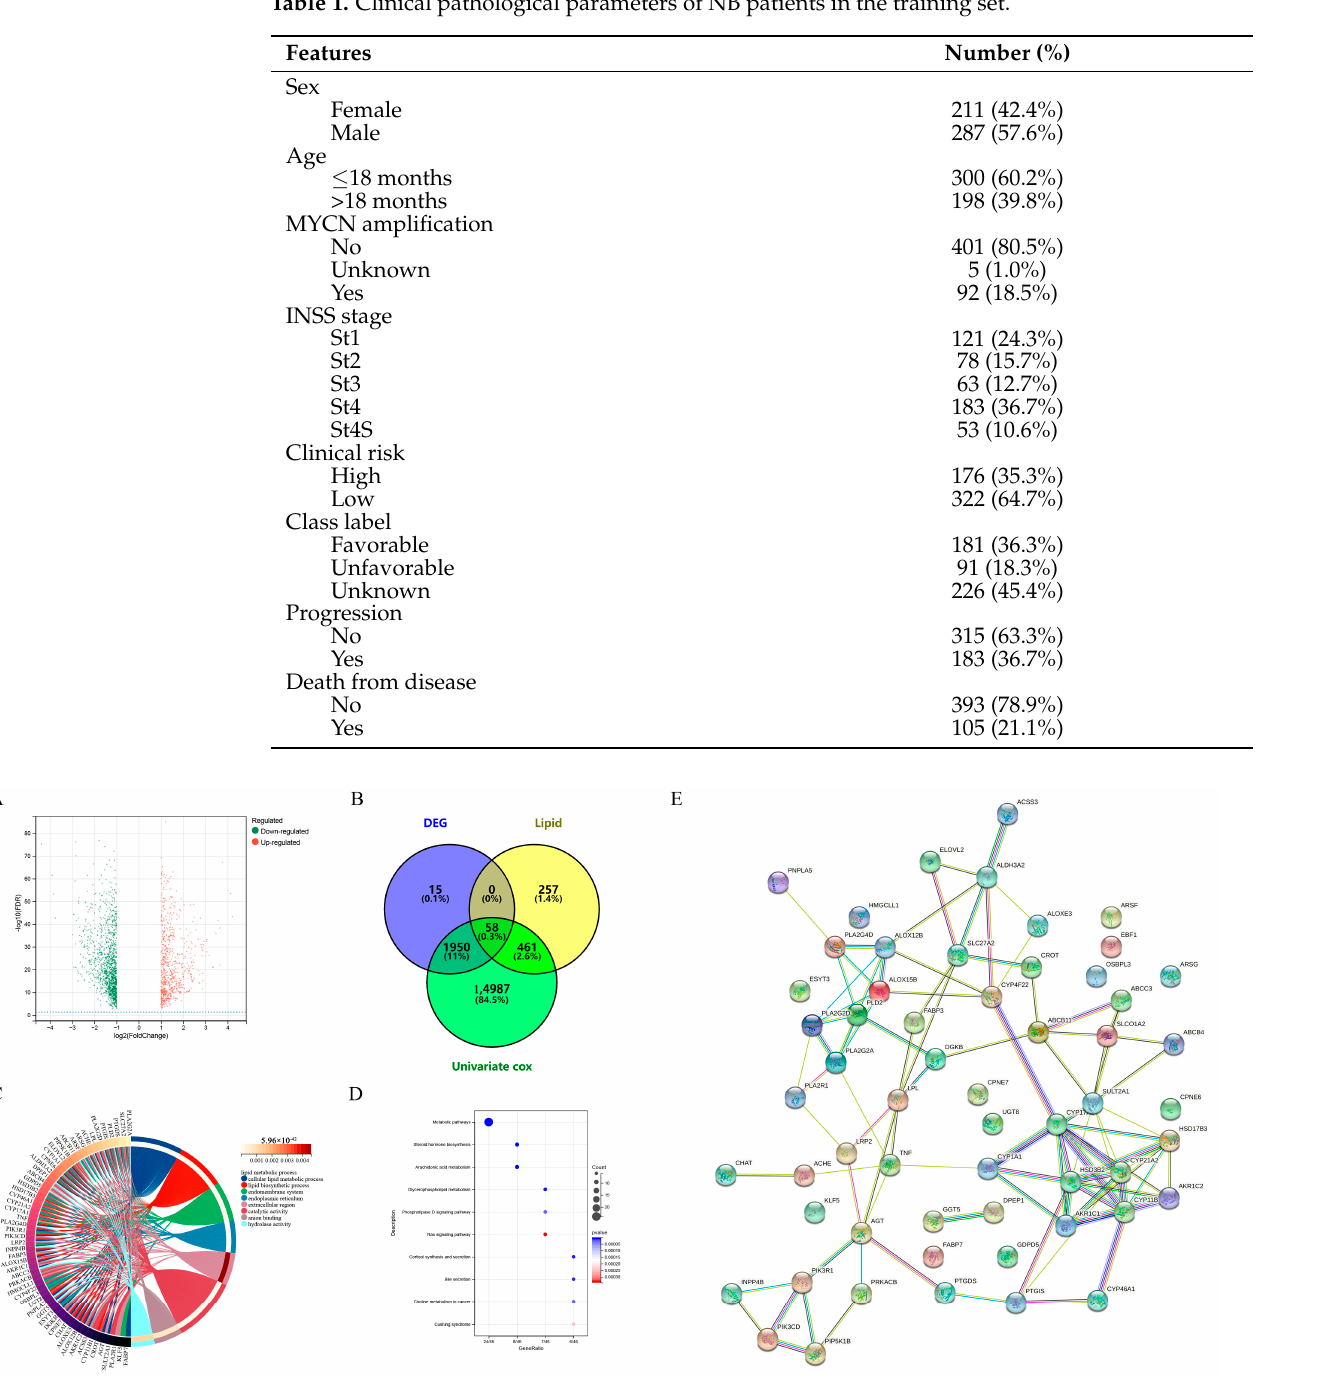
Figure 1. Discovery of differentially expressed genes and aberrant metabolic pathways in high-risk neuroblastoma. ( A ) Volcano plots of differentially expressed genes (DEGs) in the GSE49710 dataset. The x-axis represents fold change in gene expression and the y-axis represents FDR. The red and green dots in the graph represent statistically significant up- and down-regulated genes. ( B ) Venn diagrams of DEG, lipid-metabolism-related genes and genes screened by univariate CCox. ( C ) Gene ontology (GO) analysis of 58 genes. ( D ) Kyoto Encyclopedia of Genes and Genomes (KEGG) analysis of 58 genes. ( E ) Protein–protein interaction (PPI) network of 58 genes. Table 1. Clinical pathological parameters of NB patients in the training set.